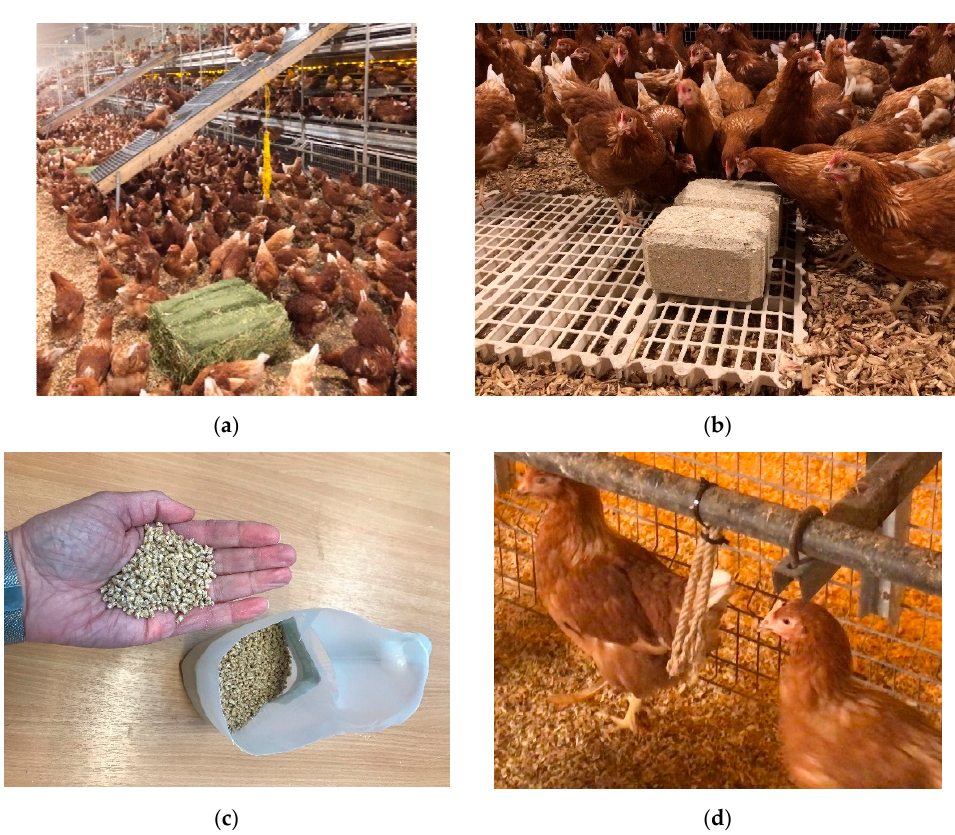
Figure 2. Enrichments: ( a ) alfalfa hay bales prior to hanging in the hay nets (yellow); ( b ) pecking blocks paired and on slats; ( c ) pelleted feed scattered from a plastic jug; ( d ) jute ropes.